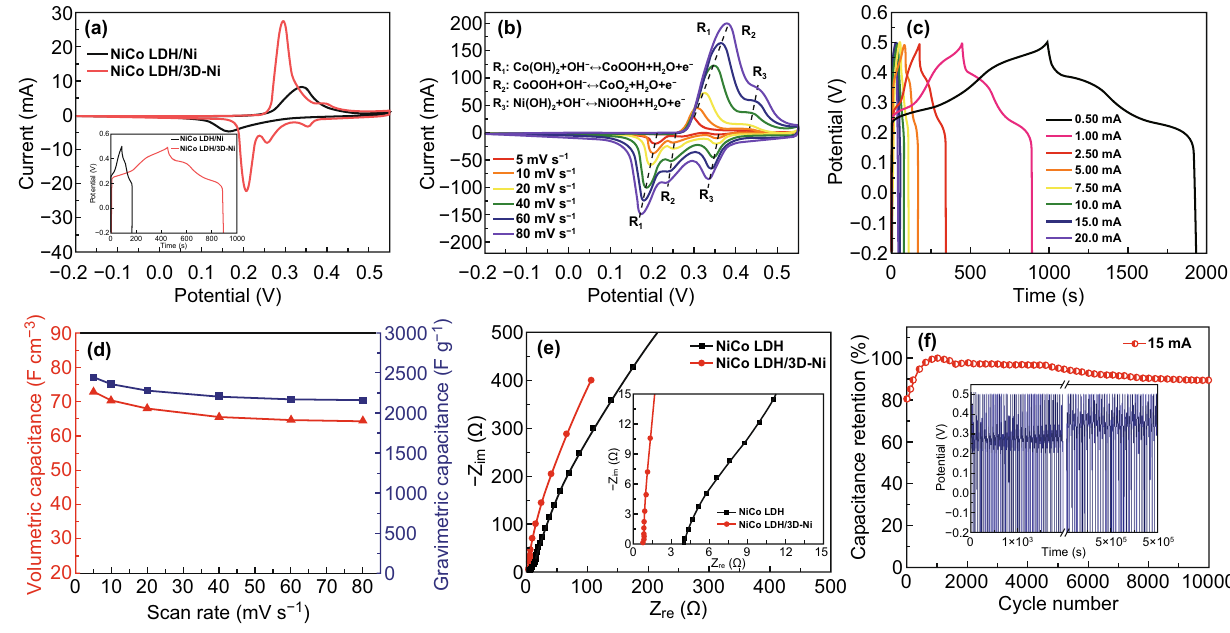
Fig. 2 a Cyclic voltammetry and charge/discharge profiles of NiCo LDH/Ni, and NiCo LDH/3D‑Ni nanostructures at a scan rate of 5 mV s −1 . b Cyclic voltammetry profiles, c galvanostatic charge/discharge profiles, and d volumetric capacitance (specific capacitance) of NiCo LDH/3D‑Ni nanostructures at different scan rates (ranging from 5 to 80 mV s −1 ). e The EIS data of the NiCo LDH/3D‑Ni electrode and the NiCo LDH/Ni electrode. f Cyclic stability obtained at a current of 15 mA (current density: 51.72 A g −1 ); the inset shows the charge/discharge